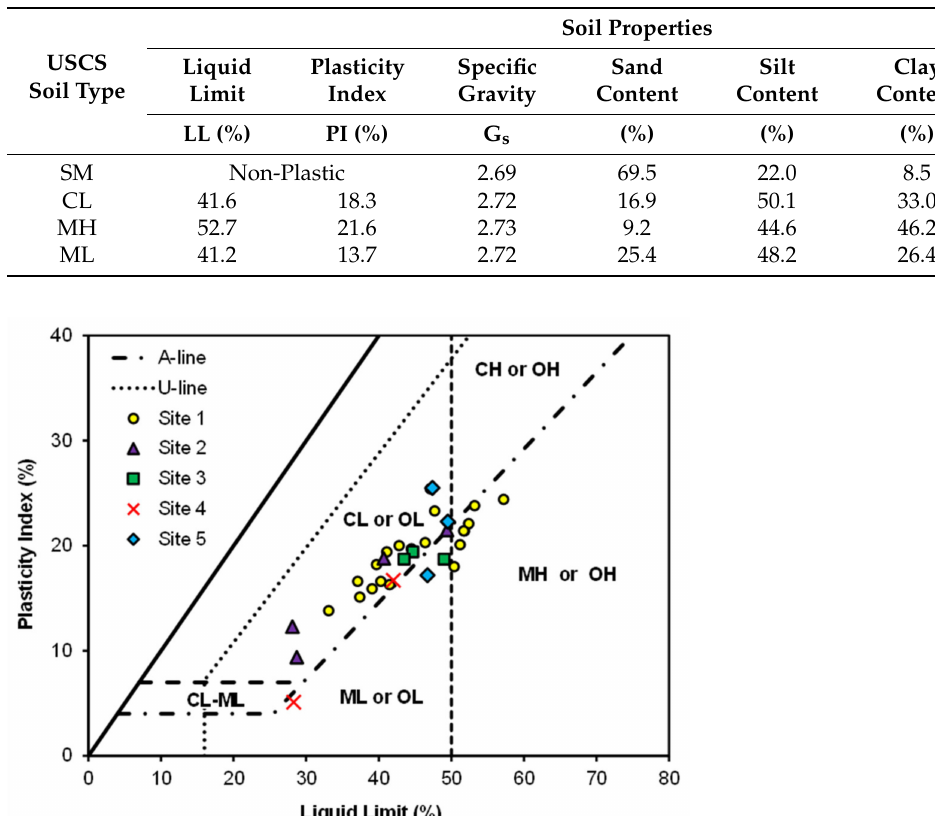
Table 1. Physical properties of riverbank soils on the lower Roanoke River.